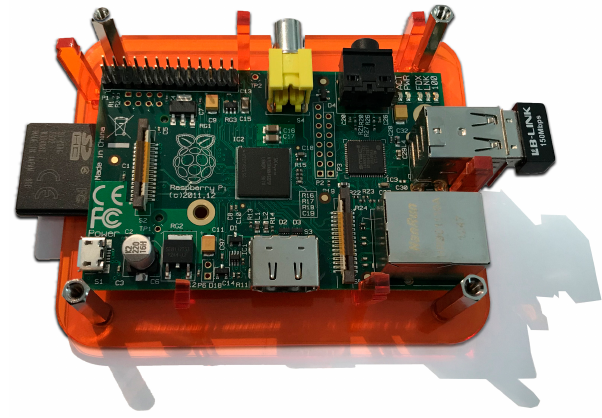
Figure 22. Raspberry Pi processor connected to the SSD subsystem.